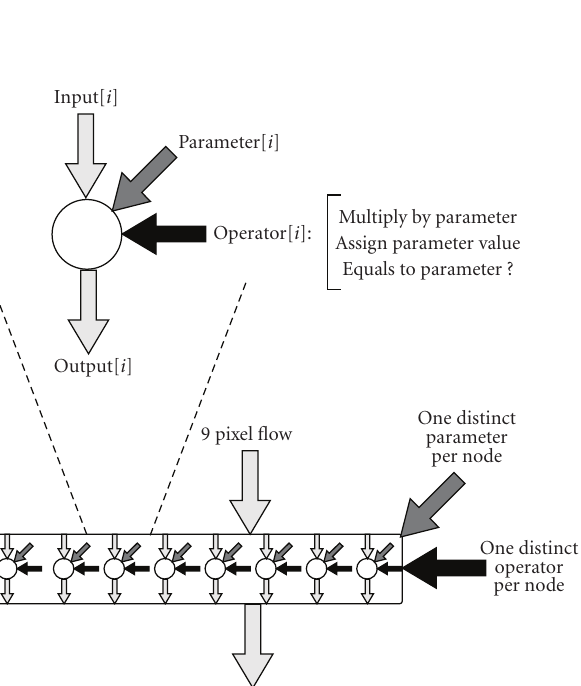
Figure 4: Moving window unit.